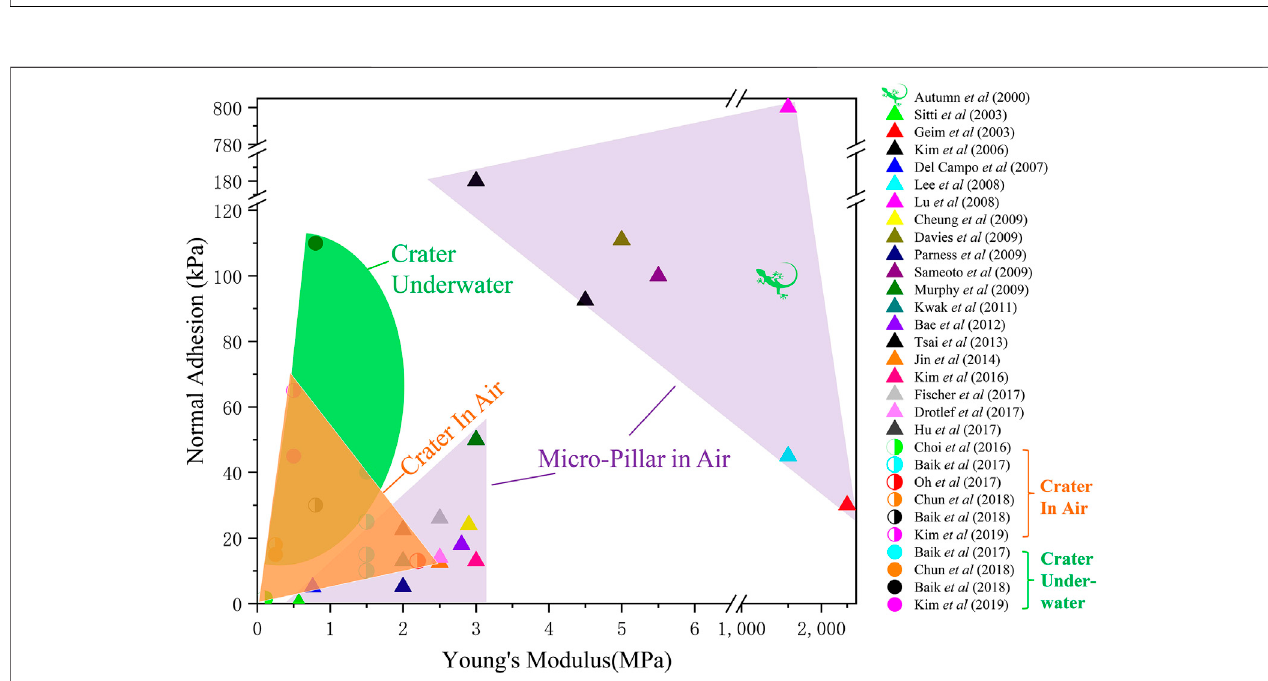
FIGURE3| AnAshbyplotofnormaladhesivestrengthvs.materialYoung ’ smodulusforbothpillar-enabledandcrater-enabledSDAs.Purpleregimesenclosedata of pillared surfaces in air. The orange regime denotes craters in air and the green regime represents craters underwater.